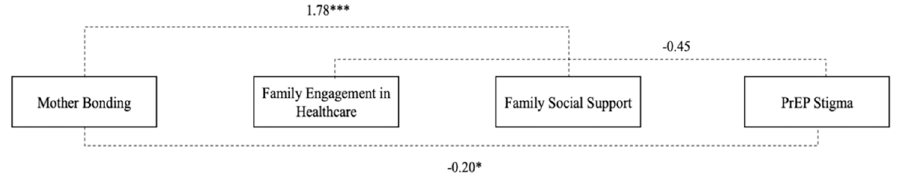
Figure 3. Pathways to PrEP stigma through father bonding ( n = 245). Note: standardized path coef- ficients presented. ** p < 0.01. Figure 4. Indirect pathways to reduction in PrEP stigma ( n = 399) through father bonding. Note: standardized path coefficients presented. * p < 0.05; *** p < 0.001. 3. Discussion The purpose of this study was to use the ecodevelopment theory to examine the im- pact of family-level factors on PrEP stigma among BLMSM. Despite the low PrEP use among BLMSM and the significant public health implications, few studies have examined the contextual factors associated with mother and father bonding, family engagement in healthcare, and family social support on PrEP stigma [13–17], making our study novel and relevant. Overall, our findings highlighted that the influence of the familial microsystem is pronounced in modifying PrEP stigma. Results also indicated that mother and father bonding predicted family engagement in healthcare, which in turn predicted family social support and reduction in PrEP stigma. These findings allow for a more nuanced under- standing of the extent to which family-level factors may affect PrEP stigma, which holds implications for the health and well-being of BLMSM. Studies examining the effects of the ecodevelopmental theory in the family context on BLMSM health, HIV, and stigma are limited [26]. Ecodevelopmental theory postulates that youth are embedded in an interrelated and interconnected context [26], and research- ers have focused primarily on the family microsystem. These study findings demonstrate the importance of family factor influences on PrEP stigma among BLMSM. This is signif- icant because our study expands the current state of the science by indicating the im- portance of the family and its dynamics within a developmental framework. Our research findings suggest that the family context contributes to engagement in healthcare, social